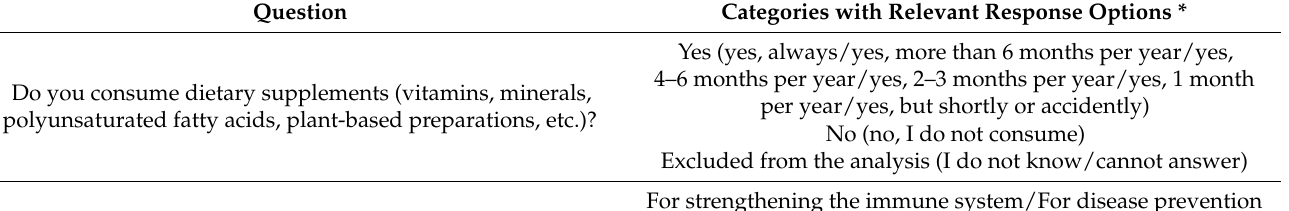
Table 2. Questions about the consumption of dietary supplements included in this